Question: Provide a publication-style caption for this figure.
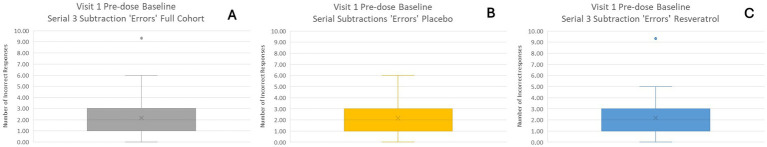
Answer: Box and whisker plot observations on visit 1, pre-dose baseline data for serial 3 subtraction ‘errors’ for the full cohort (A) , placebo condition (B) , and resveratrol condition (C) .